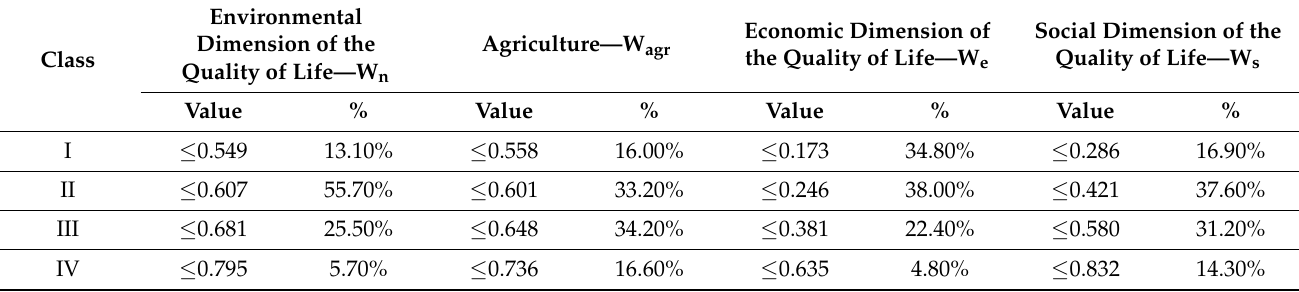
Table 4. Structure of counties based on the environmental, social, and economic dimensions of the quality of life.